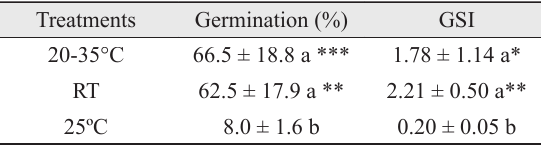
Means (± SD) of germination percentage and germination speed index (GSI) of Melocactus violaceus at three different temperature treatments (alternating temperature between 20-35°C and room temperature (RT), and a constant temperature of 25°C). Means were compared by ANOVA and different letters in same column indicate signifi cant differences according